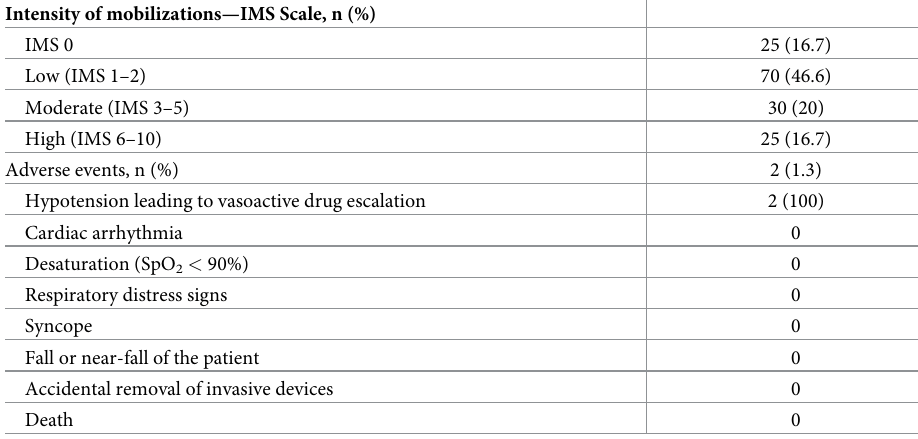
Table 5. Intensity of mobilizations and adverse